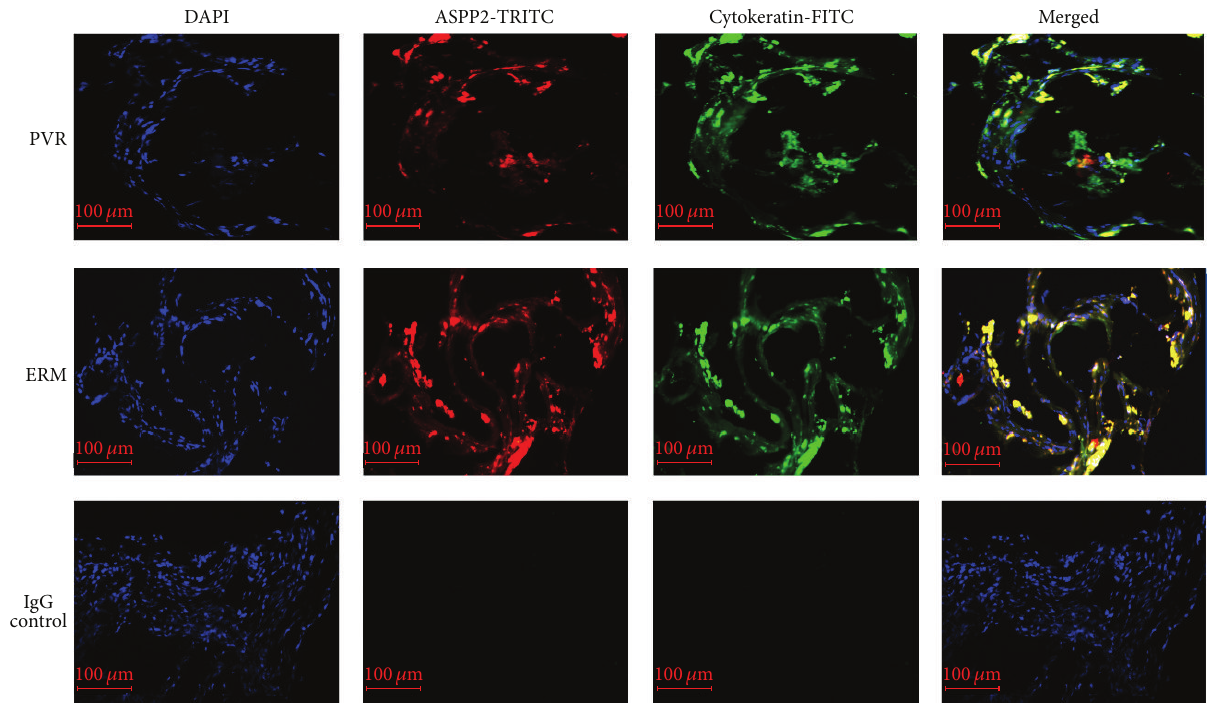
Figure 1: ASPP2 expression in PVR membranes. Fluorescence micrograph showing colocalization of ASPP2 (red) and cytokeratin (green) in both PVR membranes and ERM. Cell nuclei were stained with DAPI (blue). Isotype IgG was used for the negative control. Representative results obtained from samples of patients number 1 and number 10 are shown. PVR, proliferative vitreoretinopathy; ERM, epiretinal membranes; DAPI, 4 󸀠 ,6 󸀠 -diamino-2-phenylindole. Scale bars, 100 𝜇